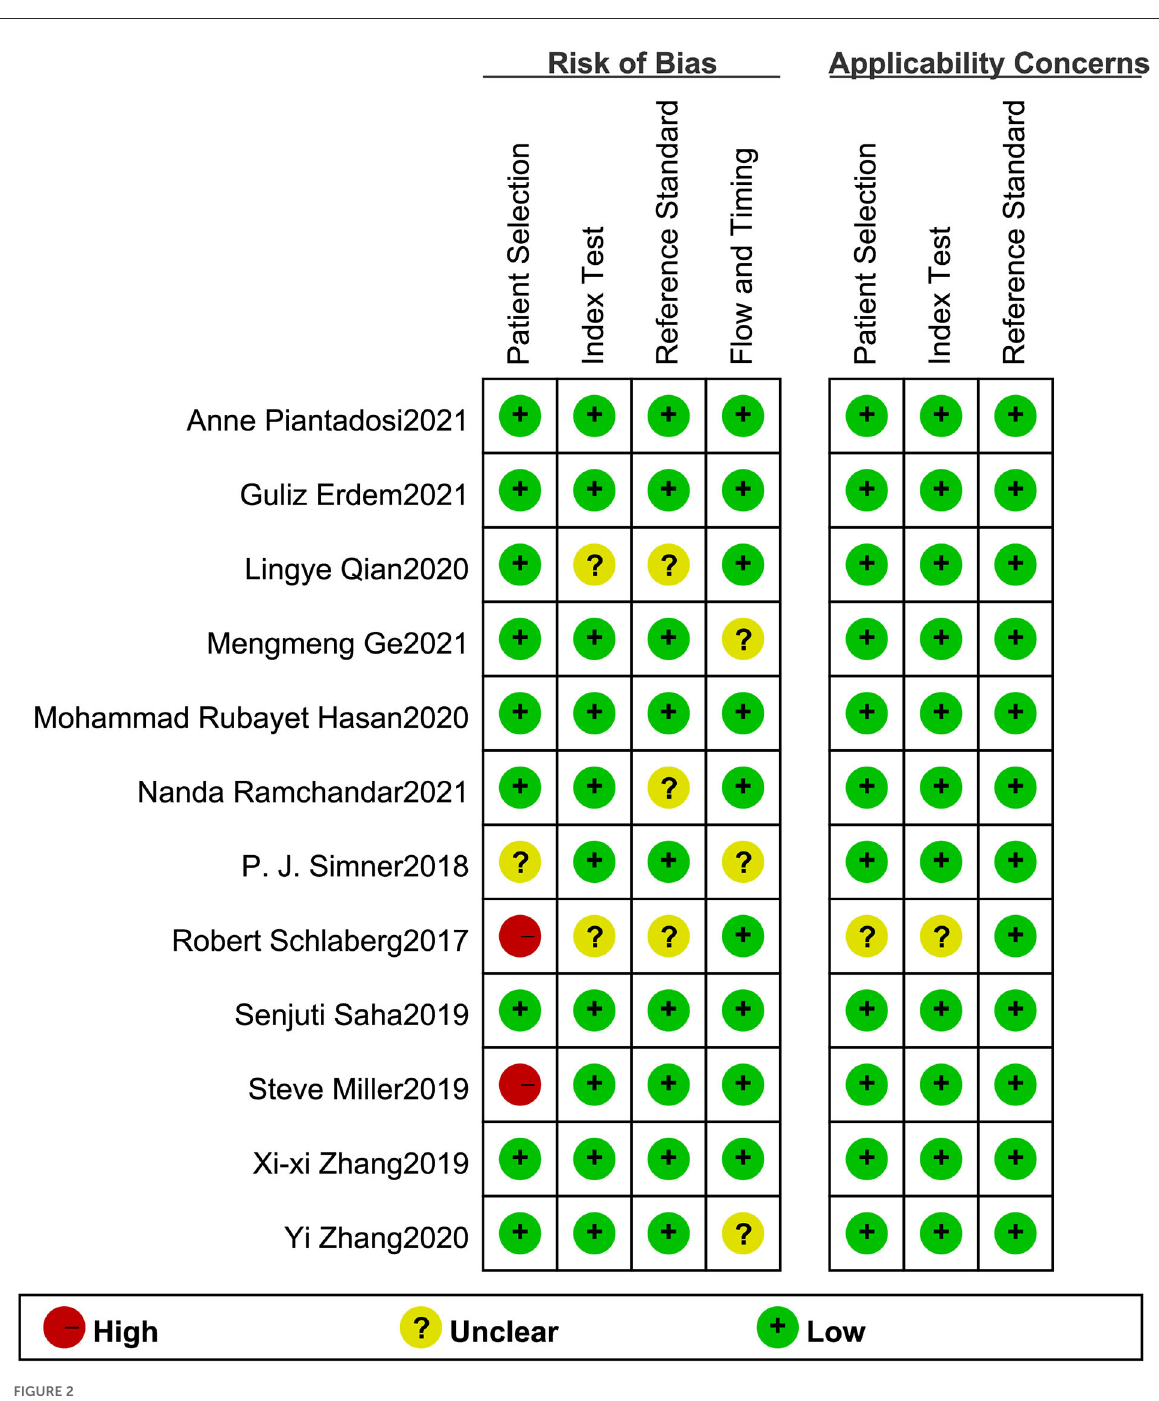
FIGURE2 Quality assessment results of included studies based on QUADAS-2 tool